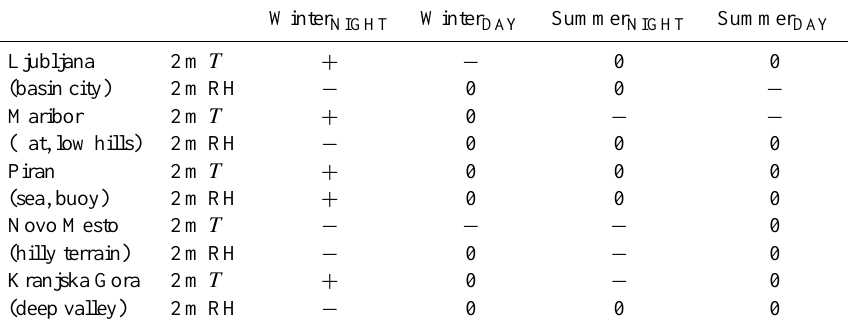
Table 3. The average daytime/night-time scores of 2m temperature (2m T ) and relative humidity (2m RH) of the 9.5km horizontal resolution run for five locations over the Slovenian domain. The + sign means improvement, 0 means neutral effect and the − sign means degradation of the scores.